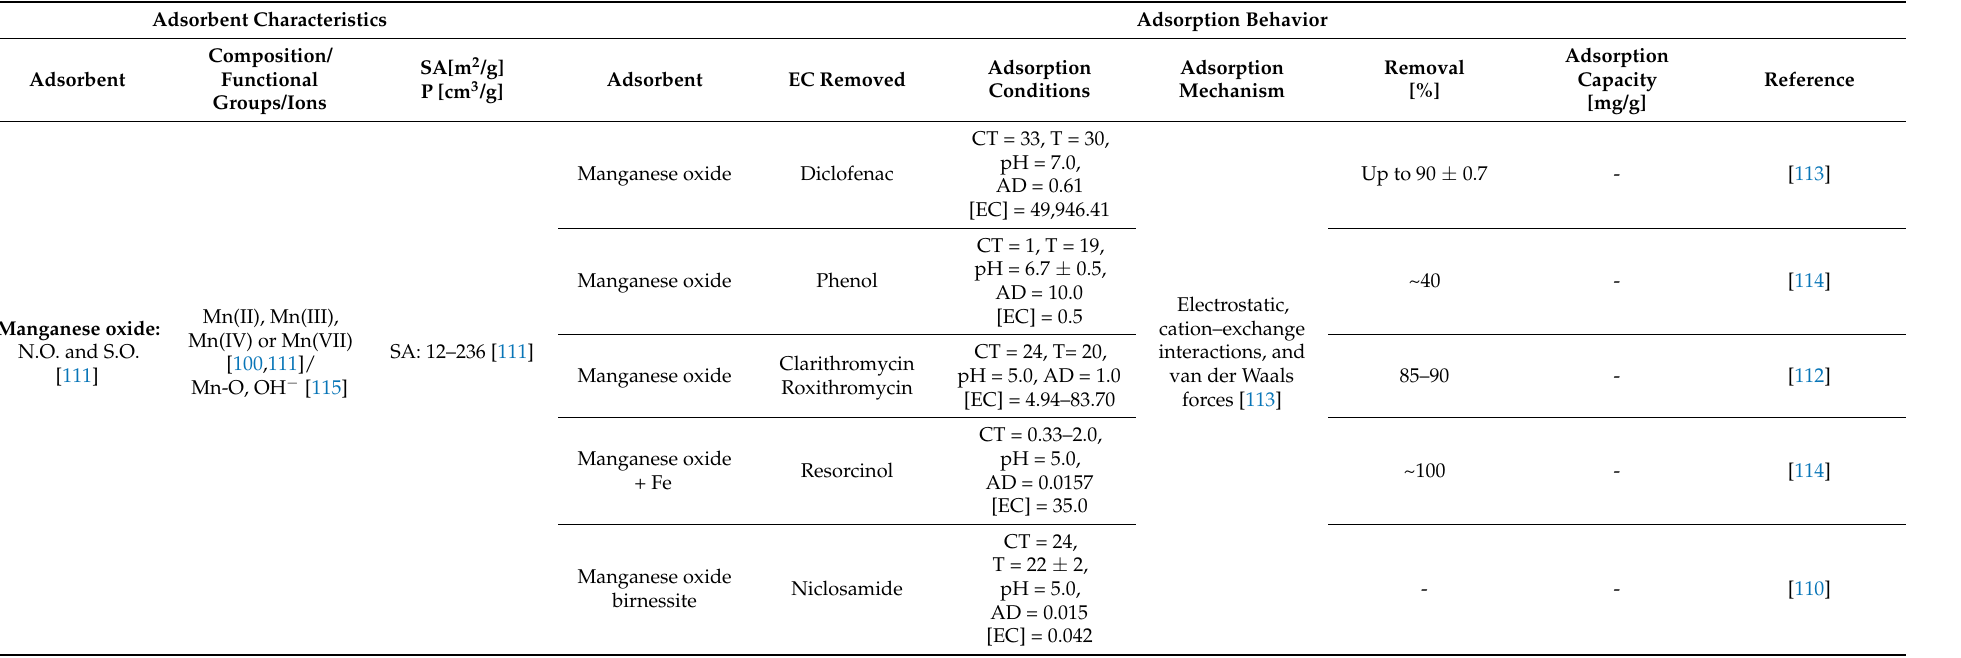
Table 3. Inorganic non-conventional materials in ECs removal using synthetic water in batch